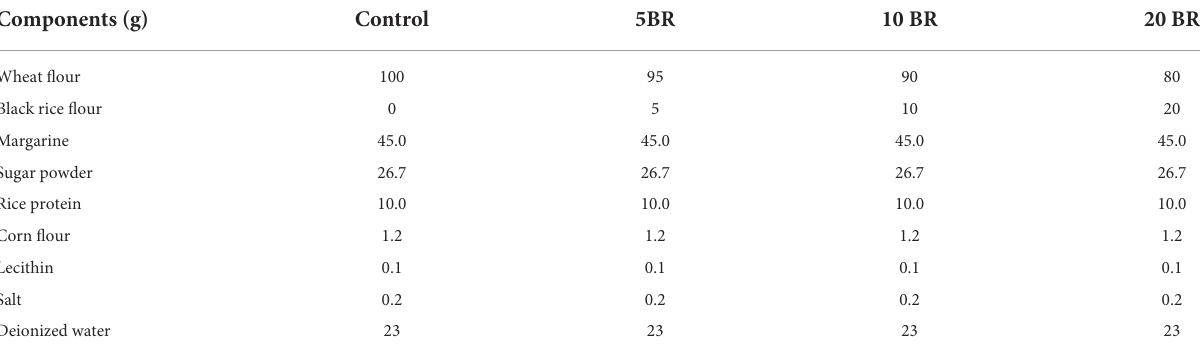
TABLE 4 Flaky egg-free rolls formulation incorporated with rice protein and different proportions of black rice flour. Components